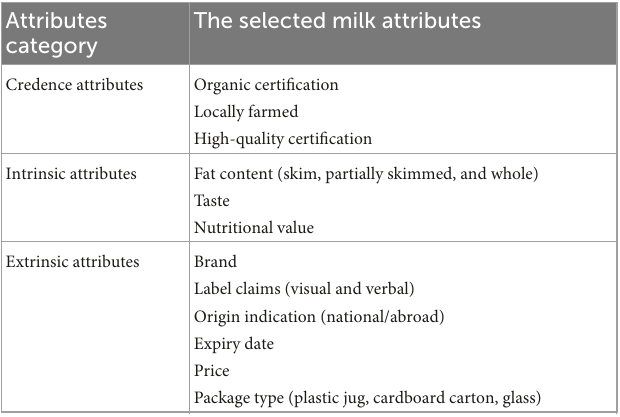
Packaging material